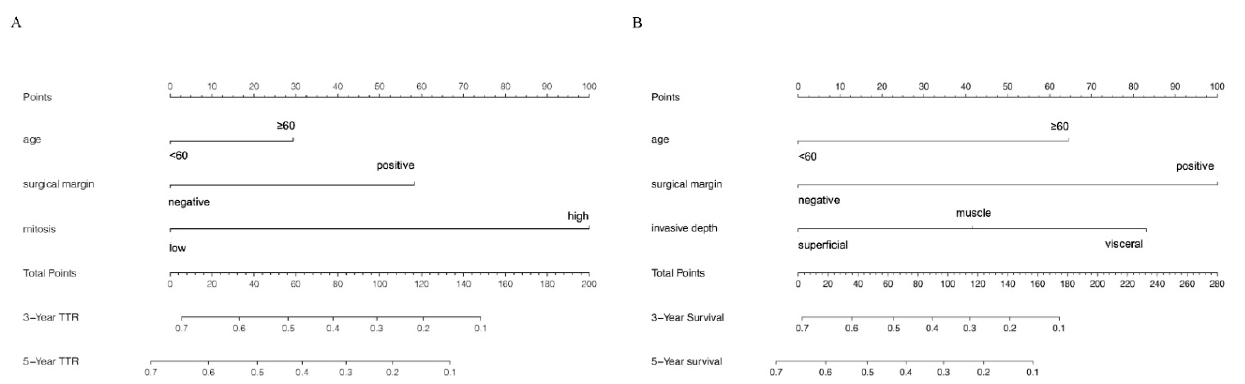
Table 1. Clinical characteristics of undifferentiated pleomorphic sarcoma (UPS) patients ( n = 116).